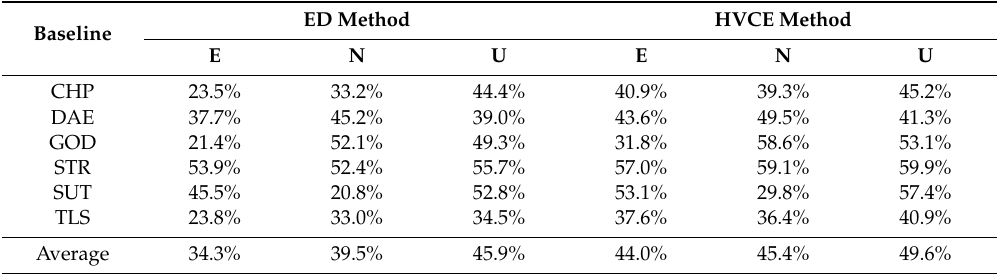
Figure 7. RMSs of kinematic relative positioning using four weighting strategies, from top to bottom: ED GPS-only ( first ), HVCE GPS-only ( second ), ED Multi-GNSS ( third ) and HVCE Multi-GNSS ( last ) from DoY 171 to 200 in 2019. Table 5. Accuracy improvement percentages of Multi-GNSS strategies based on ED and HVCE compared with the corresponding GPS-only strategies from DoY 171 to 200 in 2019.